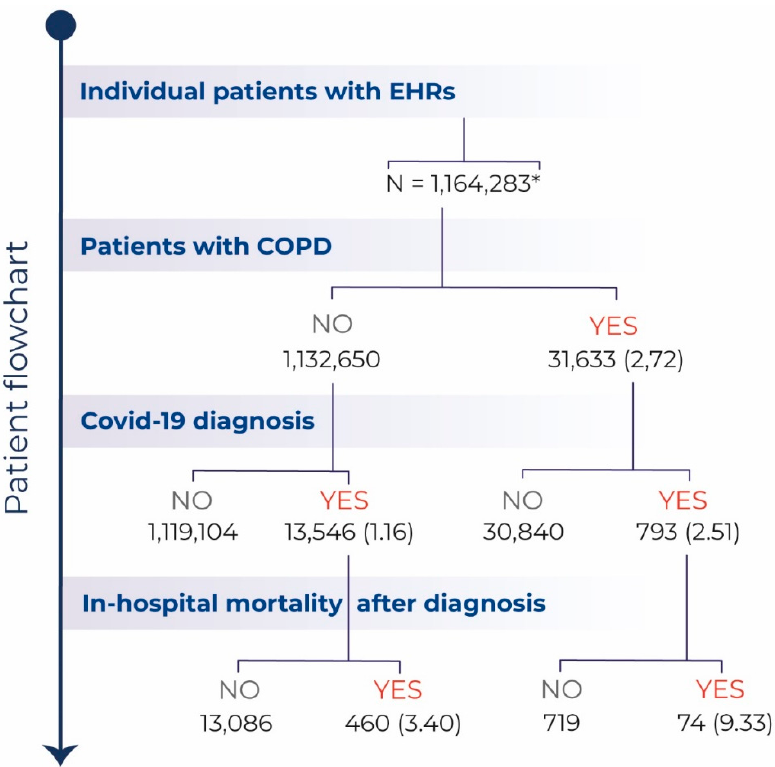
Figure 1. Patient Flowchart. Flowchart depicting the total number (%) of patients with available electronic health records (EHRs) during the study period (1 January 2019–10 May 2020), the number of patients with COPD seen during this period, the number of patients diagnosed with COVID-19, and of those, the number of deaths after diagnosis. All percent values are computed in relation to the level immediately above. * Patients aged > 40 years.